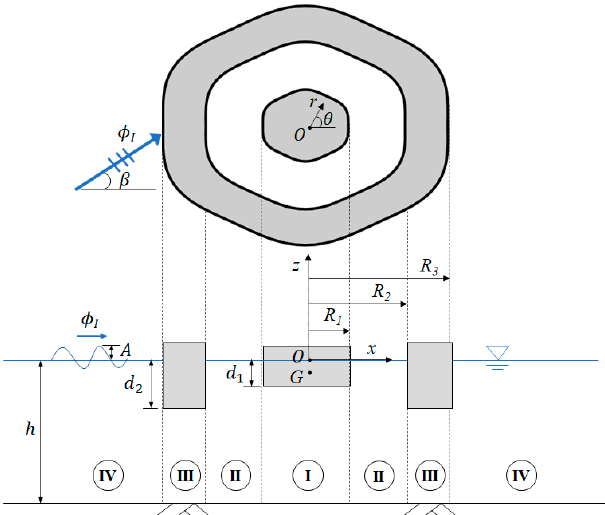
Figure 2. Floating polygonal platform and ring breakwater.